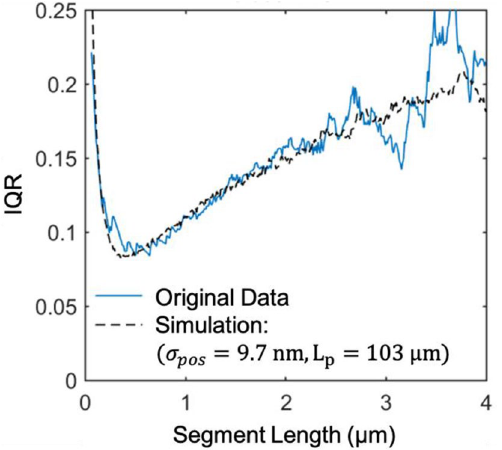
Figure 2. Interquartile range for the distribution of angle changes as a function of segment length. Experimental data for a kinesin surface density and ATP concentration of 500 μm −2 and 1 mM (blue, solid line). Simulation of a microtubule undergoing a persistent random walk with persistence length L P corrupted with uniformly distributed noise on (cid:31)